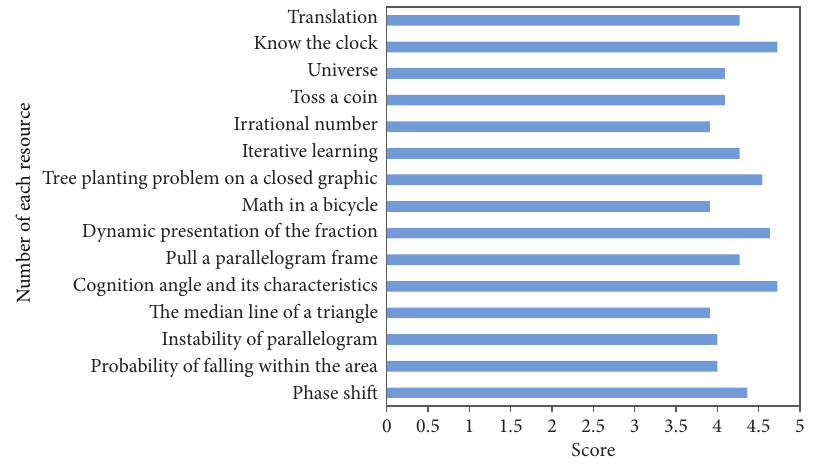
Figure 7: Rating of the picture previews.